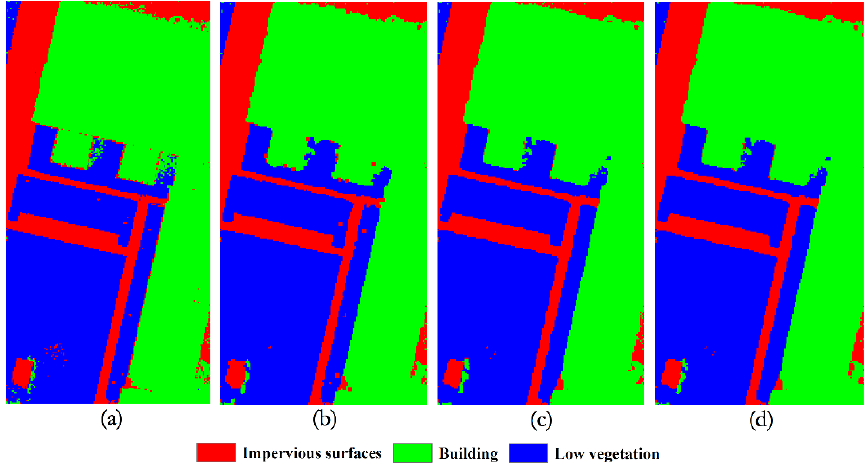
Figure 10. Classification maps of Beijing2 image: ( a ) OCM, ( b ) RCM_SU, ( c ) RCM_SDU, and ( d ) RCM_CU.